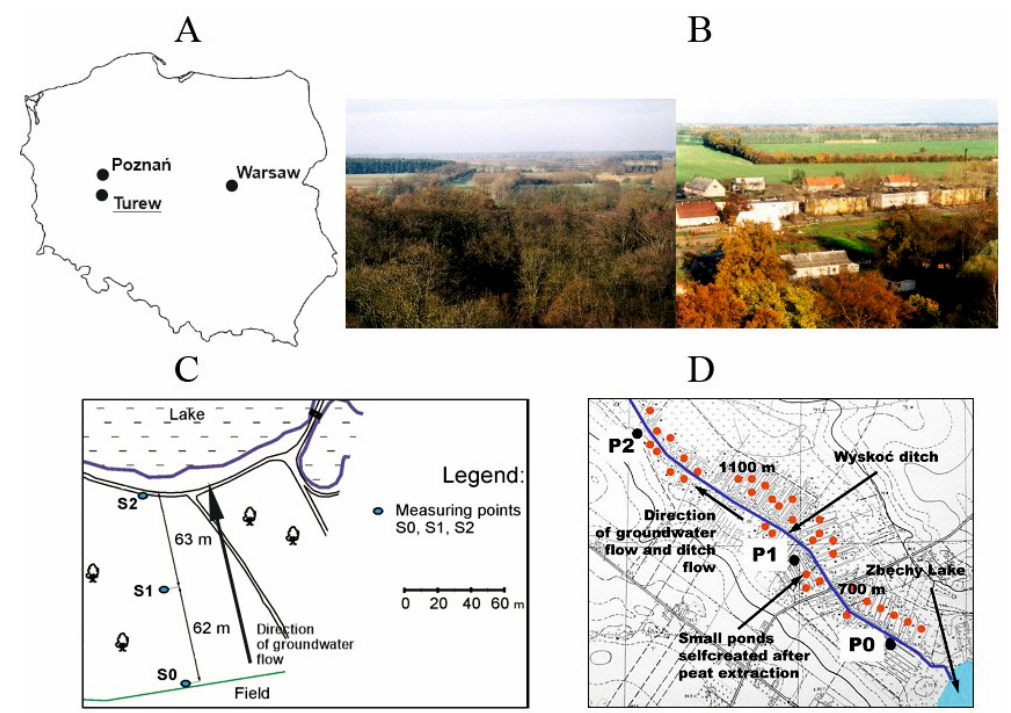
Figure 1. ( A ): Schematic map of Poland and the location of Turew Village; ( B ): the landscape of Turew and the system of shelterbelts; ( C ): map of 125 m long shelterbelt in Turew Park, ( D ): scheme of 1800 m investigated peatland.